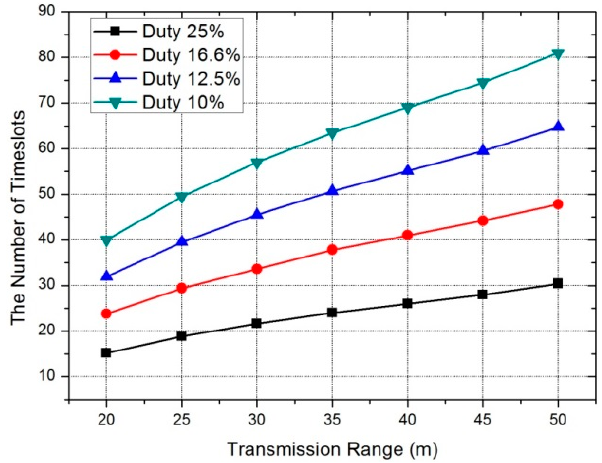
Figure 11. Schedule length according to duty period.